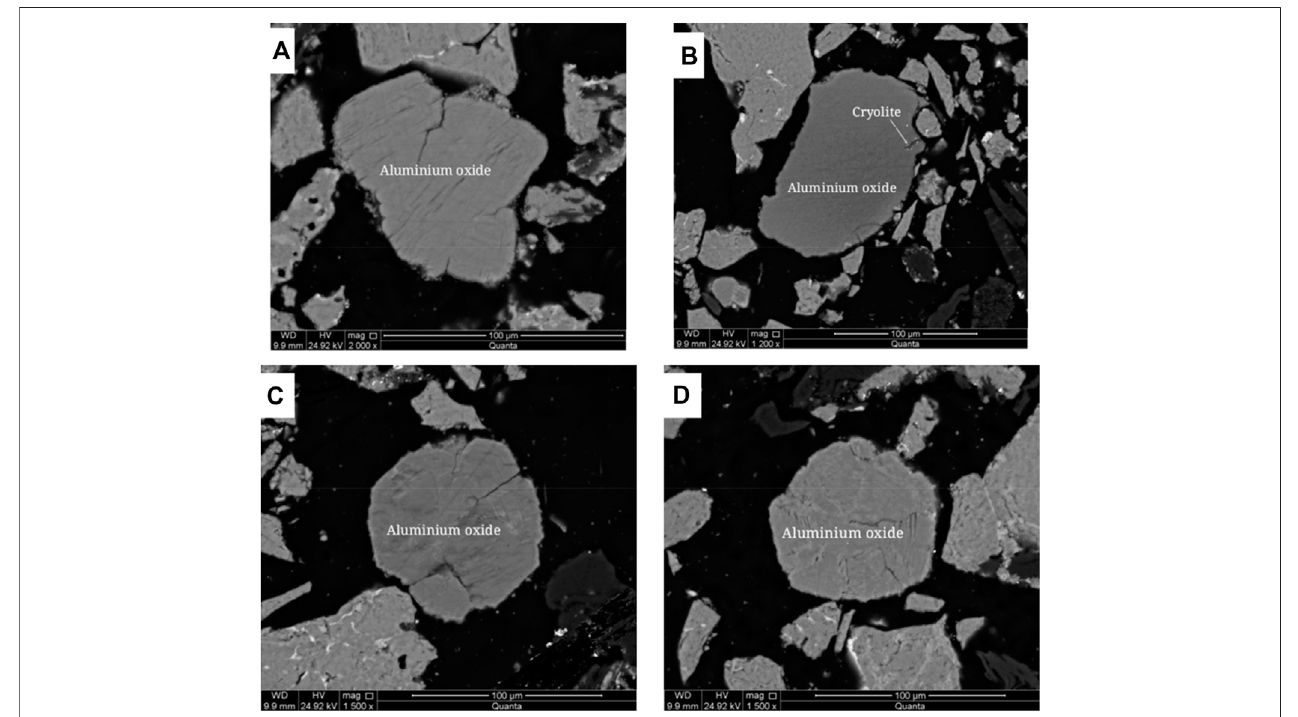
FIGURE 13 | Scanning electron microscope backscattered electron image of Polydymite (Polydymite as crushed granular).